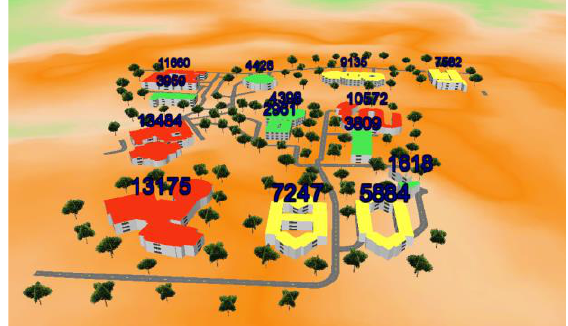
Figure 5. 3D Model using SRTM